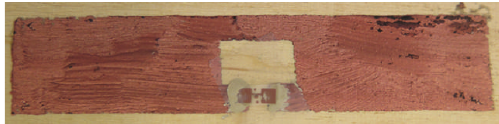
Figure 9: Fabricated copper